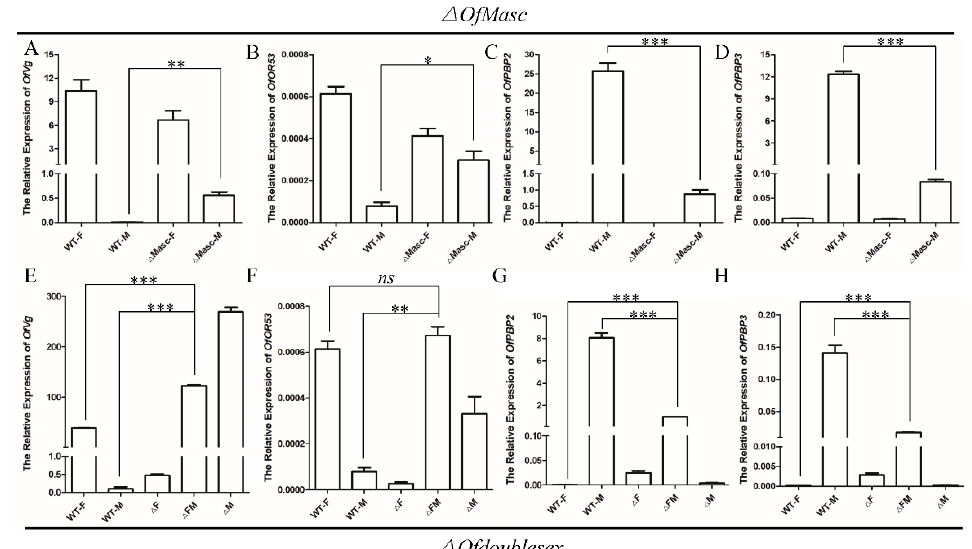
Figure 5. qRT-PCR analysis of the putative downstream genes of Ofdsx in the OfMasc and Ofdsx mutants. ( A – D ) Relative mRNA expression levels of OfVg , OfOR53 , OfPBP2 , and OfPBP3 in OfMasc mutants. ( E – H ) Relative mRNA expression levels of OfVg , OfOR53 , OfPBP2 , and OfPBP3 in Ofdsx mutants. Three individual biological replicates were performed using qRT-PCR. Error bar: SD; *, ** and *** represent significant differences at the 0.05, 0.01 and 0.001 levels ( t -test) compared with the control.